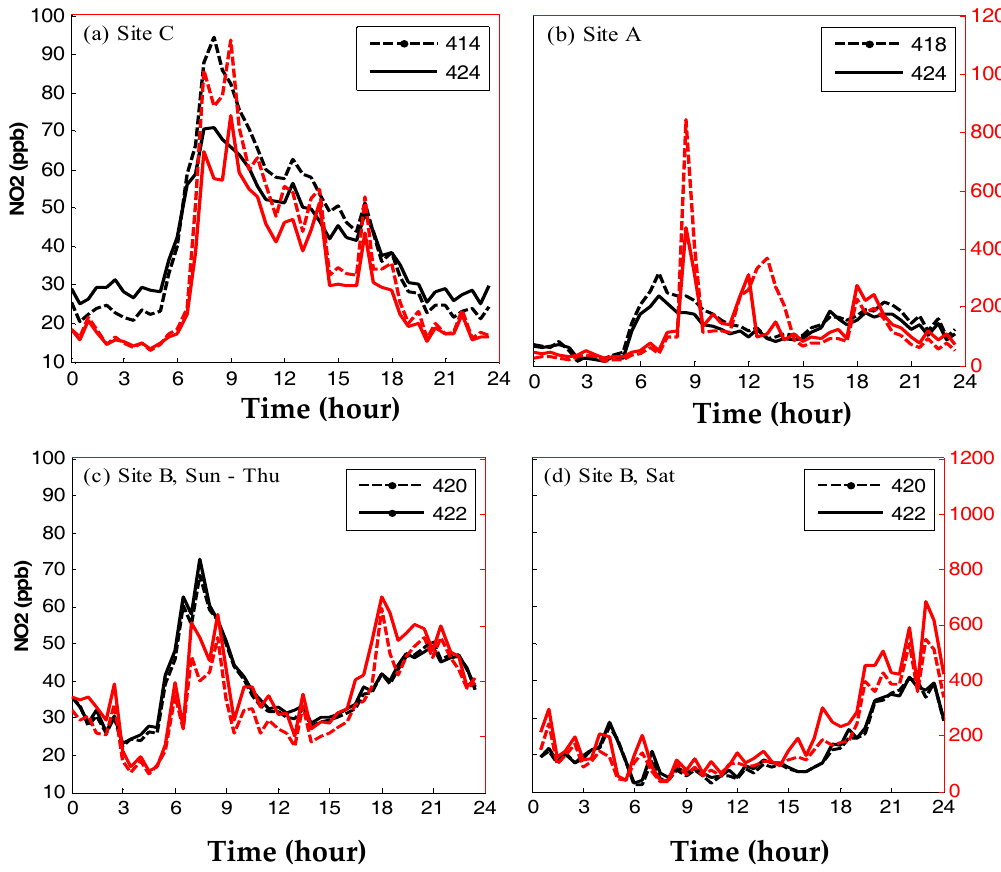
Figure 2. Daily patterns of 30 min average NO 2 (black) and total volatile organic compounds (TVOC) (red) concentrations in ( a ) site C during weekdays (Sunday to Thursday); ( b ) site A during weekdays (note the adaptation of node 424 to its microenvironments upon relocation); ( c ) site B during weekdays; and ( d ) site B during Saturdays. The MSUs were deployed in a residential neighborhood after they were calibrated while collocated at an AQM station within the neighborhood. (Reproduced with permission from